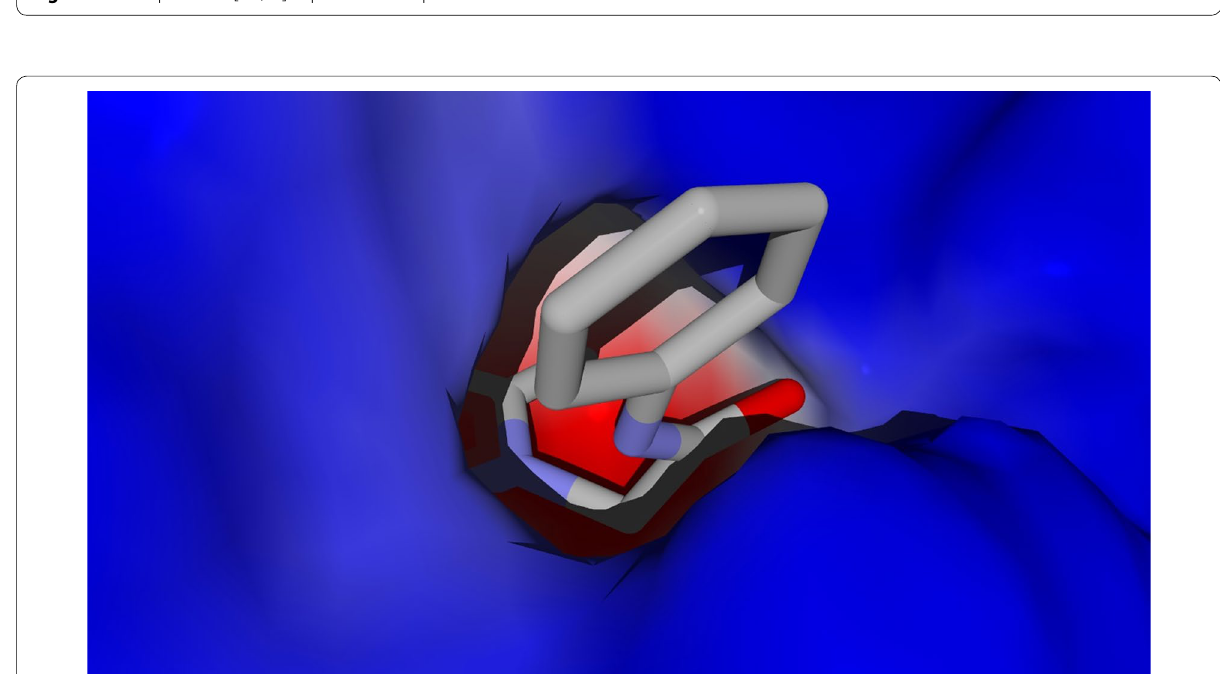
Fig. 9 Docking pose of compound 2e within the HNE ligand-binding